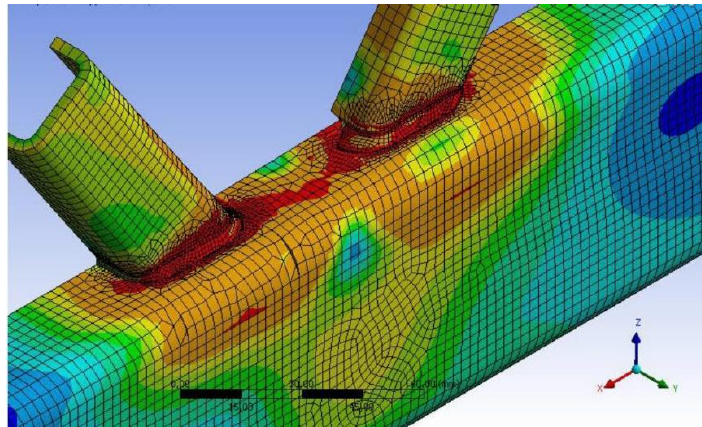
Figure 14. Failure in joint KB4 with semi-circular hole and brace angles of 55°.